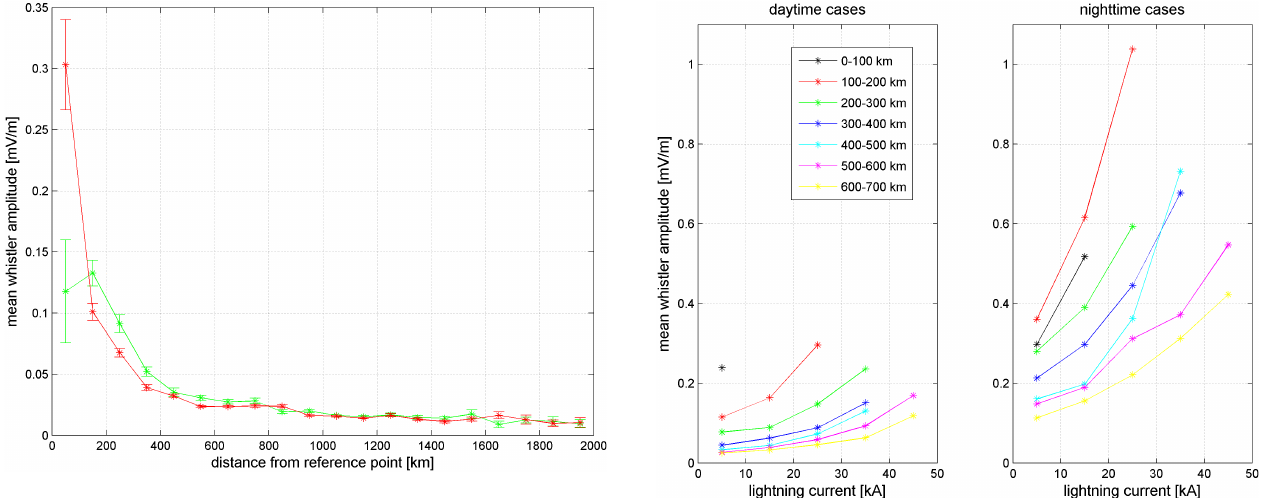
Fig. 9. Mean whistler amplitudes as a function of lightning current for fixed distances (colour-coded) between the reference point and locations of lightning. Left: Daytime cases, right: Nighttime